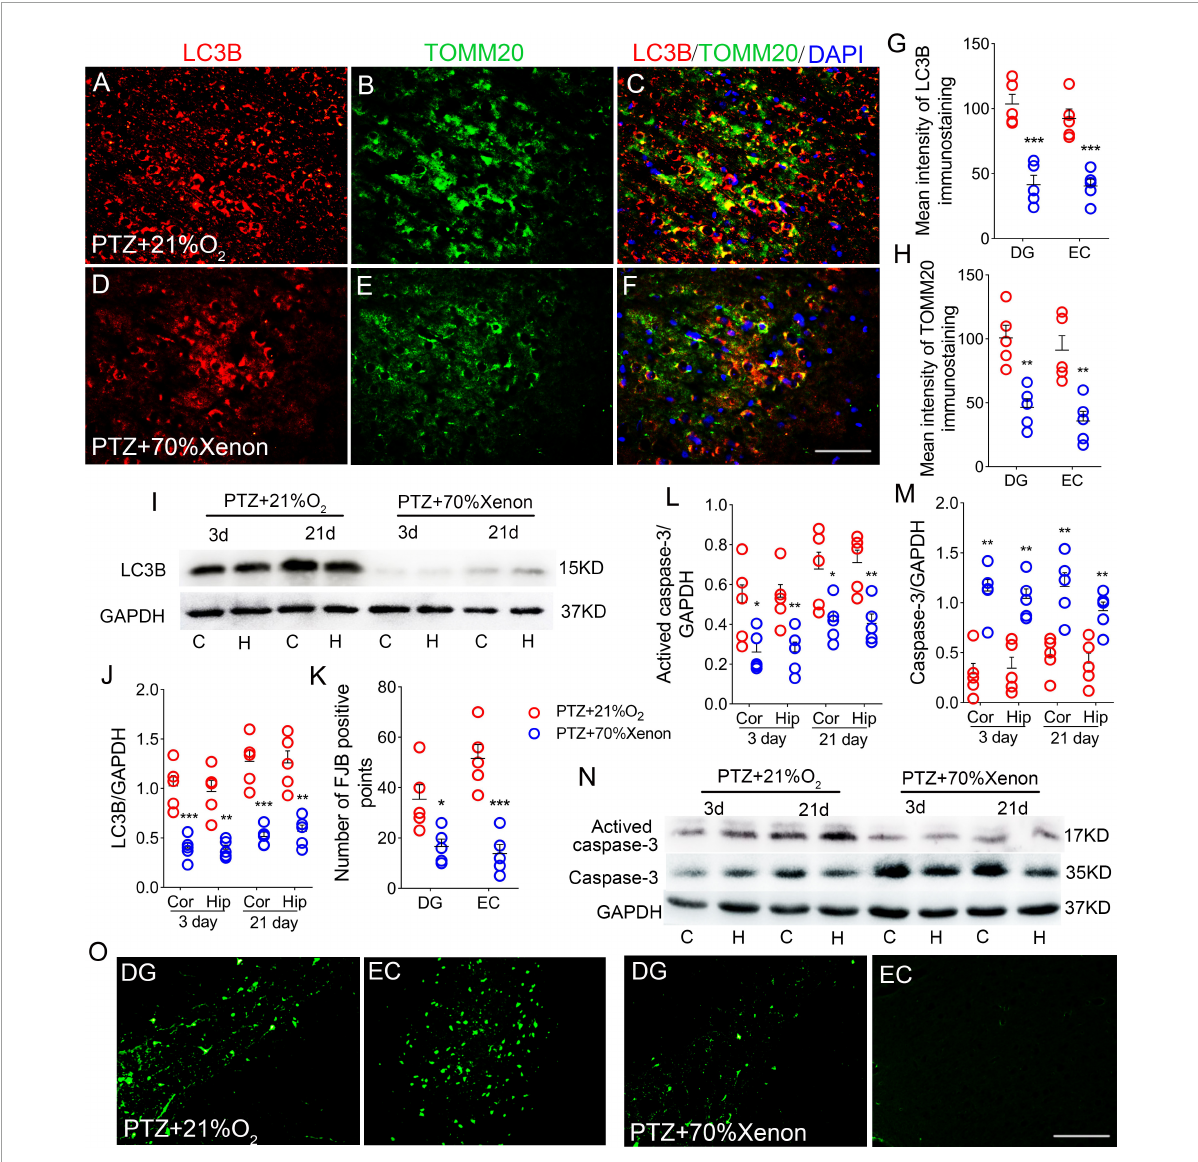
FIGURE8 Xenon treatment prevented pentylenetetrazole (PTZ)-induced autophagy/mitophagy and neuronal injury. (A–F) Decreased fluorescence intensity of LC3B (red) and TOMM20 (green) in the EC region due to xenon treatment ( n = 5/group; blue, DAPI). Bar = 60 µ m. (G,H) Quantified changes in LC3B and TOMM20 ( n = 5/group). (I) Expression of LC3B in the hippocampus and cortex estimated by western blotting ( n = 5/group). (J) Normalized levels of LC3B relative to GAPDH. (L–N) Levels of caspase-3 and activated caspase-3 in the hippocampus and cortex estimated by western blotting ( n = 5/group). (K,O) Positive FJB signals counted in each group. * P < 0.05, ** P < 0.01, and *** P < 0.001, compared with controls (unpaired T